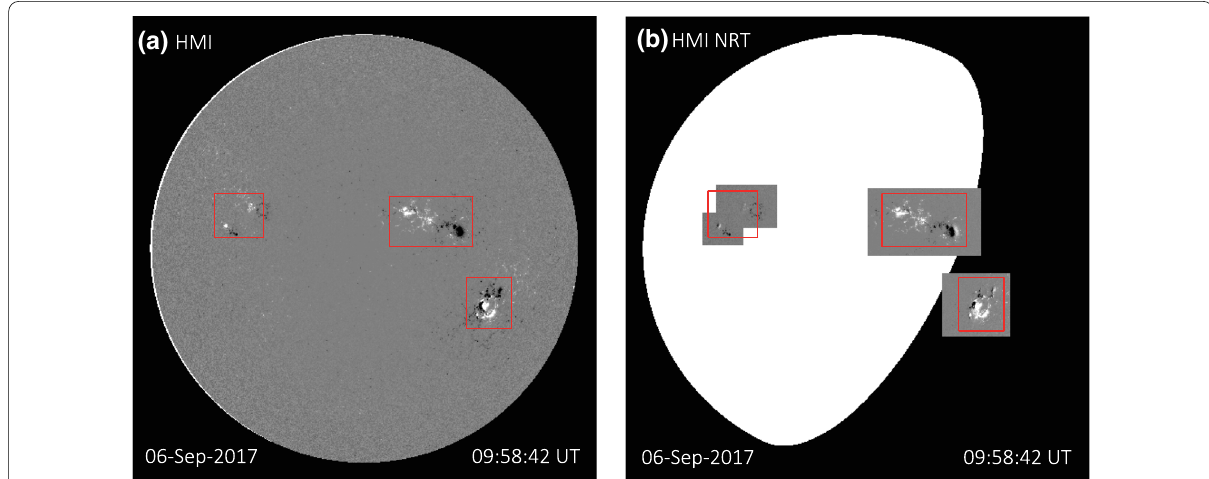
Fig. 2 Full solar disk vector magnetograms taken by HMI/SDO on 6 September 2017. a HMI definitive series data for the full disk and the areas detected by DeFN with red frames. b HMI NRT data showing the HARP areas in gray scale and the areas detected by DeFN. Note that both HARP and DeFN areas overlapped each other. If DeFN areas are outside the HARP areas, the data are set to